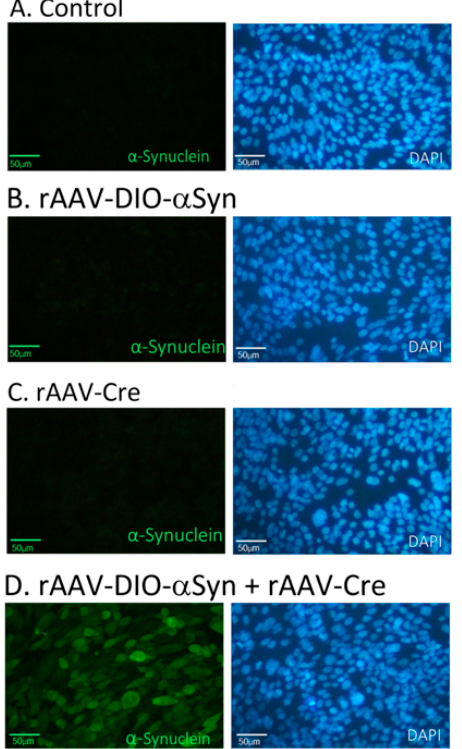
Figure 3. Expression of α -synuclein by Cre-DIO in cultured CHO cells. CHO cells were left untrans- duced (as a control; A ) or transduced with the adeno-associated virus AAV-DIO- α Syn ( B ), AAV-Cre ( C ), or rAAV-DIO- α Syn+AAV-Cre ( D ). The expression of α Syn was identified by the presence of the V5 tag. V5- α Syn immunoreactivity (green) was found only in CHO cells co-transduced with AAV-DIO- α Syn and AAV-Cre. Cell nuclei were stained with DAPI (blue). Bar: 50 μ m.